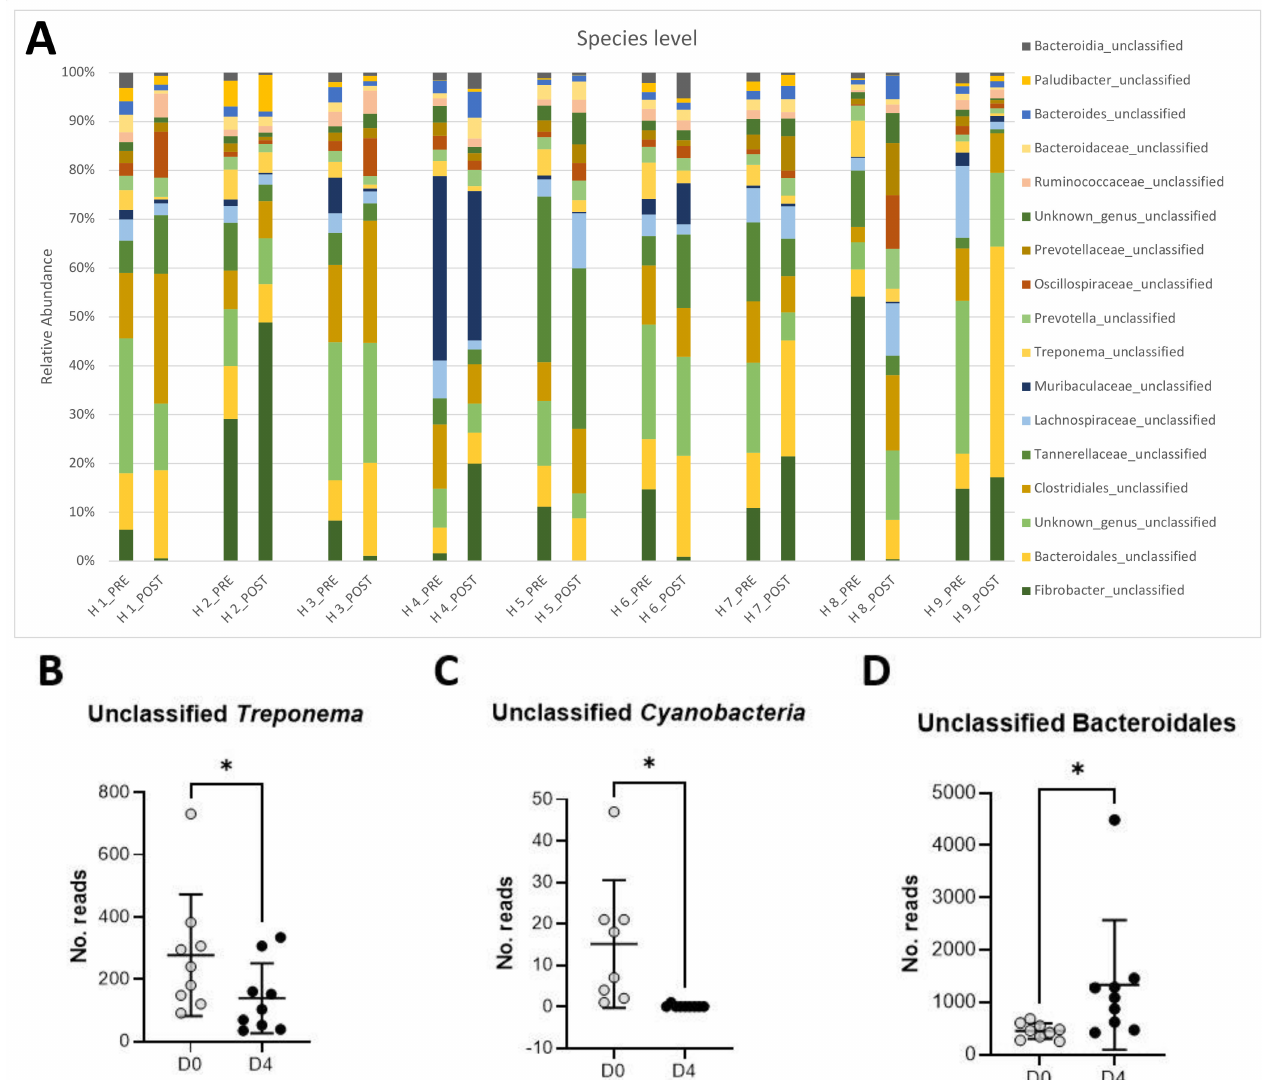
Figure 1. Changes in relative abundances of the main taxa (>1% abundance) present in the equine feces of 9 horses pre- and post-antibiotic administration of oral trimethoprim sulfadiazine ( A ). Relative abundance of unclassified Treponema ( B ), unclassified Cyanobacteria ( C ), and unclassified Bacteroidales ( D ) pre- (D0) and post-antibiotic administration